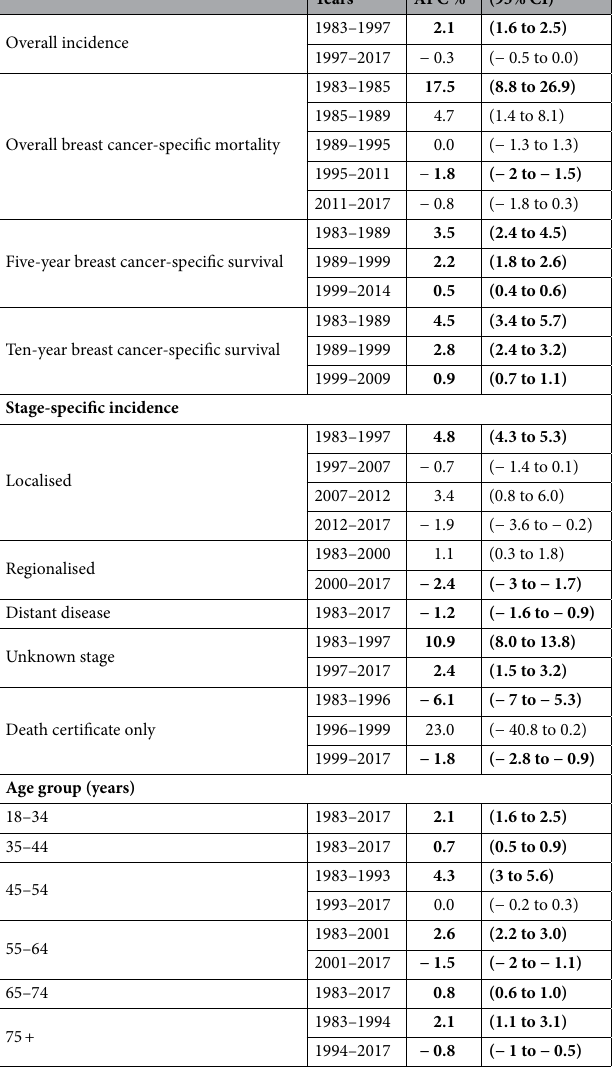
Table 2. Annual percent changes in overall breast cancer incidence, breast cancer-specific mortality, breast cancer-specific five-year and ten-year survival, and stage-specific and age-specific breast cancer incidence in women in Austria, 1983–2017. Bold indicates statistically significant results ( p value < 0.05, corrected using the Bonferroni–Holm method). APC annual percent change, CI confidence